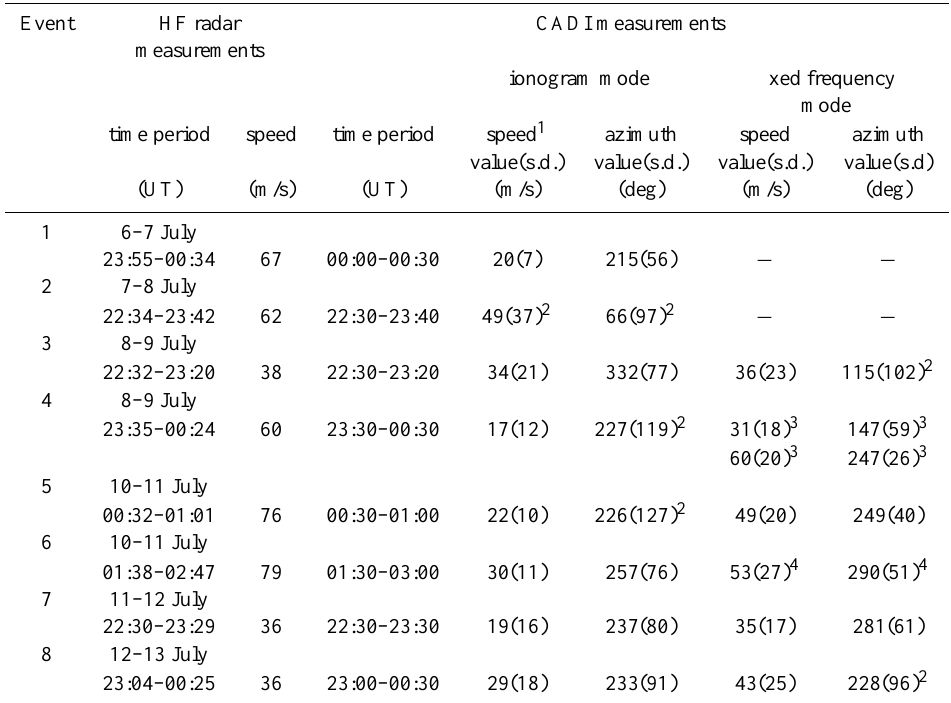
Table 1. Table of the 8 events comparing the drift measurements from the ATI HF radar analysis (EW zonal drifts only) to both the ionogram and fixed frequency mode analysis (drift speed and horizontal